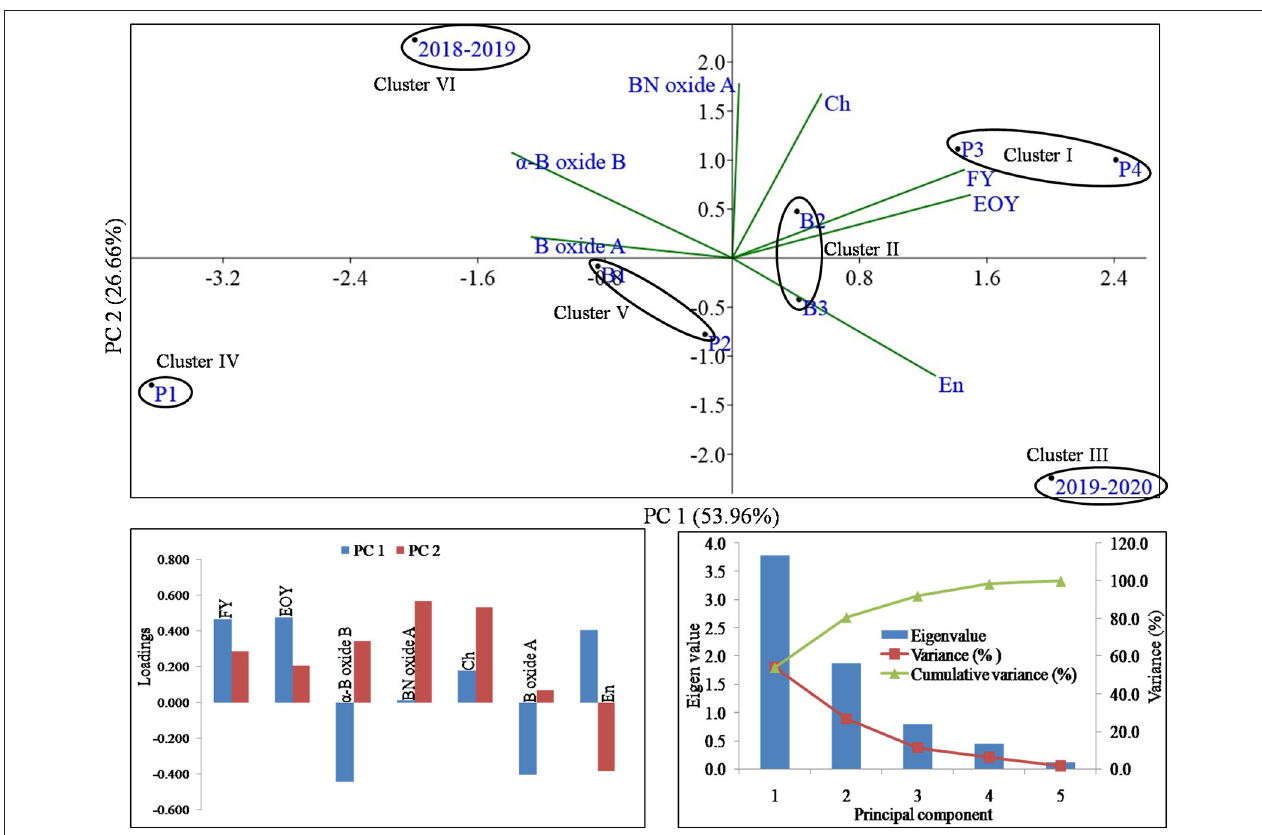
FIGURE 6 | The multivariate analyses of mean value of growth parameters, yield and major compounds of essential oil were conducted through principal component analysis. PC1 and PC2 jointly explained the variations of 80.62%. The loading values of variables and treatment combinations are presented as vectors in the space of the PCA. The eigenvalues and loading scores of the variables with PC1 and PC2 are presented in the bottom left and right corner, respectively. FY, dry flower yield (t ha − 1 ); EOY, essential oil yield (Kg ha − 1 ); α -B oxide B, α -bisabolol oxide B; BN oxide A, bisabolone oxide A; Ch, chamazulene; B oxide A, bisabolol oxide A; En,